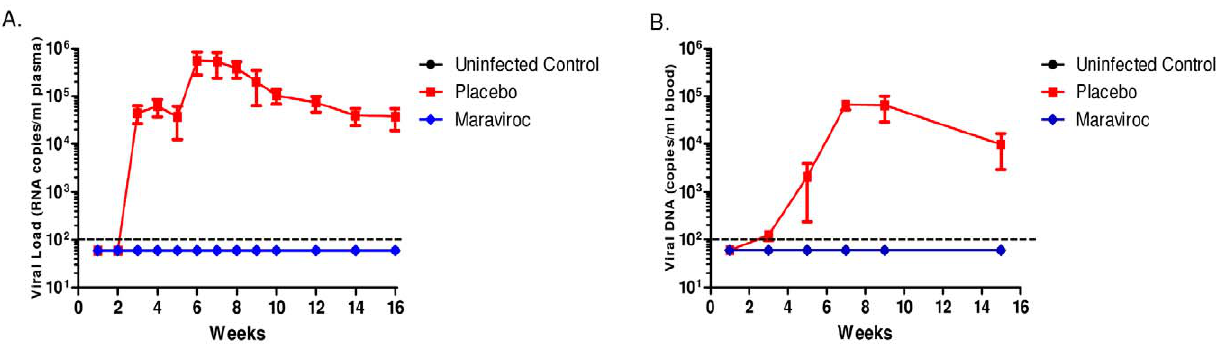
Figure 2. RNA and DNA viral loads in mice administered with maraviroc. RAG-hu mice were challenged by vaginal route after an hour after vaginal application of maraviroc as described in Methods. Blood was collected weekly. Viral RNA was extracted from the plasma fraction and DNA was extracted from the cellular fraction. Viral RNA and DNA loads were determined by Q-PCR as described in methods. The dotted lines represent limits of PCR detection. A. RNA viral loads B. DNA viral loads.